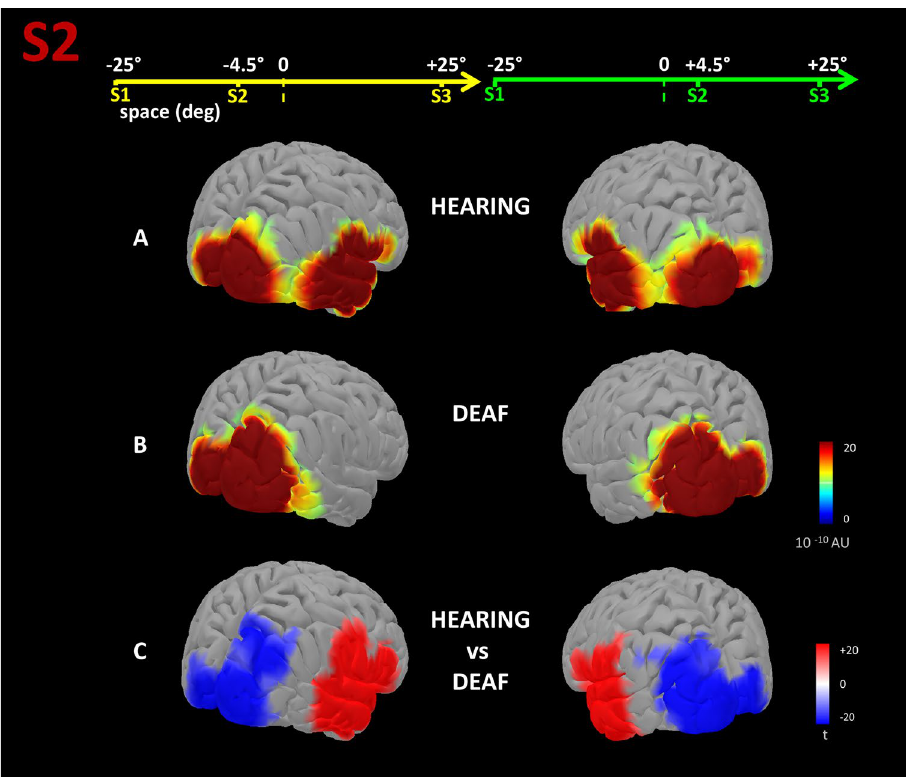
Figure 7. Average source activities within the 50 – 90 ms time window after S2 of the time-bisection task, are compared between hearing and deaf participants. Left and right panels report the conditions in which S2 was delivered from the left (i.e. − 4.5°) or the right (i.e. 4.5°), respectively. Average normalized source activation for hearing ( A ) and deaf ( B ) groups is reported in arbitrary (normalized) units (AU). Last line ( C ) reports the results of two-tailed t-tests; the scale is in terms of t-statistics. Significant values of t-statistics are displayed: reddish and bluish colors indicate stronger activations in time- and space-bisection tasks, respectively, while the intensity indicates the magnitude of t (i.e. the strength/significance of the difference). Only t-values corresponding to p < 0.0001 after FDR correction are